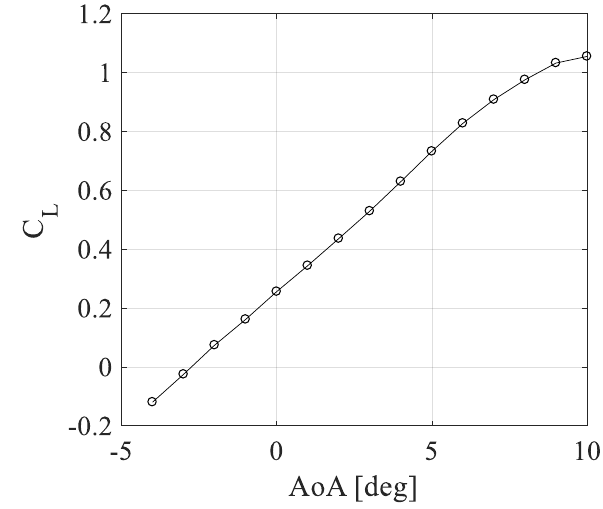
Figure 4. Lift coefficient versus AoA.